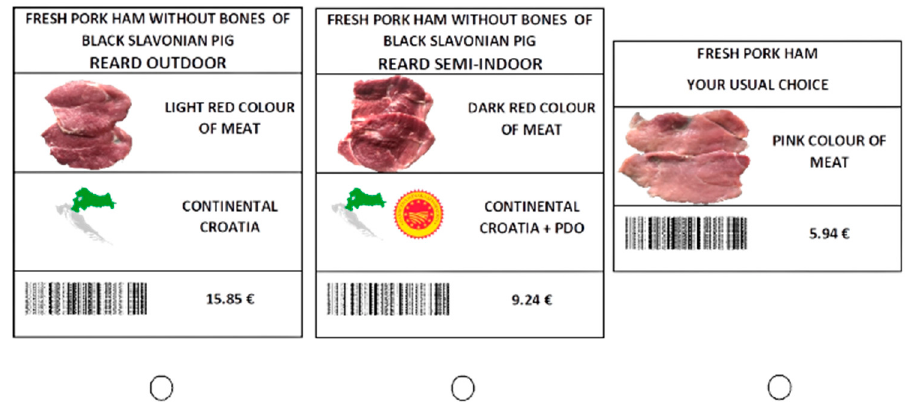
Figure 1. Example of a choice task.